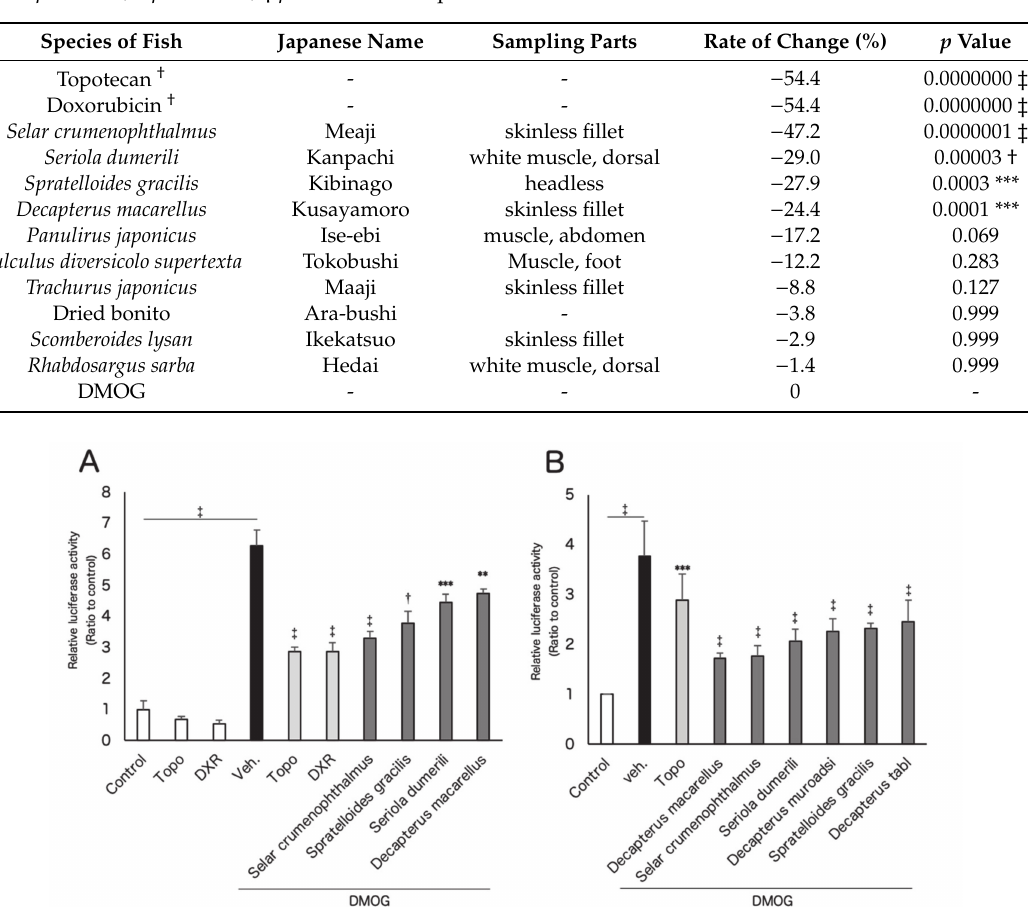
Table 1. The list of fishes showing hypoxia-inducible factor (HIF) inhibitory e ff ects in the second screening with statistical analysis and the rate of change of HIF activity compared with dimethyloxalylglycine (DMOG)-administrated controls ( n = 3). ( † Positive control chemicals)